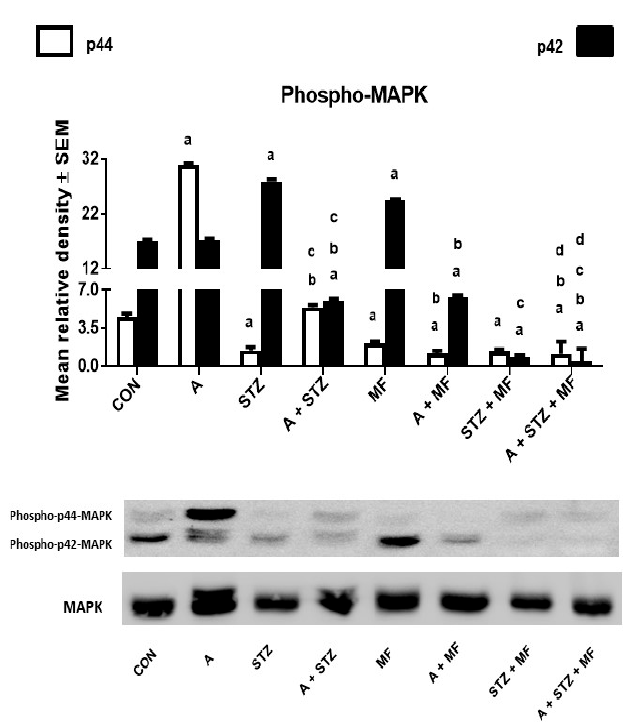
Figure 6. The renal concentration of phospho-p44 or phospho-p42 mitogen-activated protein kinase (MAPK) in control (CON) rats, and those treated with adenine (A, 0.25% w/w in feed), streptozotocin (STZ, 55 mg/kg by intraperitoneal injection), metformin (MF, 200 mg/kg/day), or a combination of these treatments. Each vertical column with bar represents the mean ± SEM (from 6 rats in each group). Differences between the groups were assessed by one-way analysis of variance (ANOVA) followed by Bonferroni’s multiple comparison test, where p < 0.05 was considered significant. a denotes significant difference between control group vs. different groups; b denotes significant difference between the group given A alone vs. other groups treated with A; c denotes significant difference between the group given STZ alone vs. other groups treated with STZ; d denotes significant difference between the group given A + STZ vs. other groups treated with A + STZ; e denotes significant difference between the group given MF only vs. other groups treated with MF.